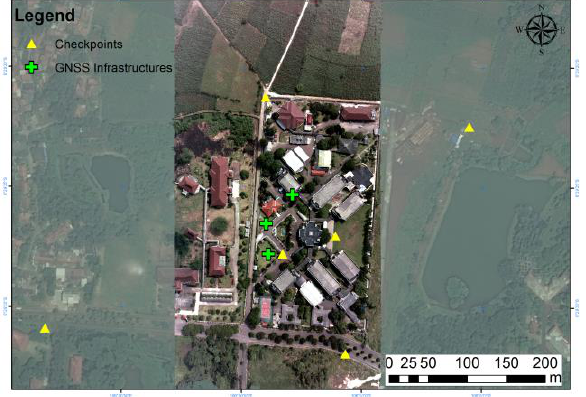
Figure 2. Area of Interest (BIG’s office, Indonesia)